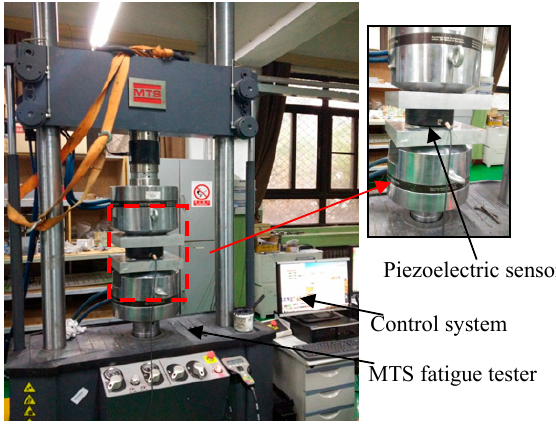
Figure 21. MTS fatigue tester for low-frequency harmonic force experiments.